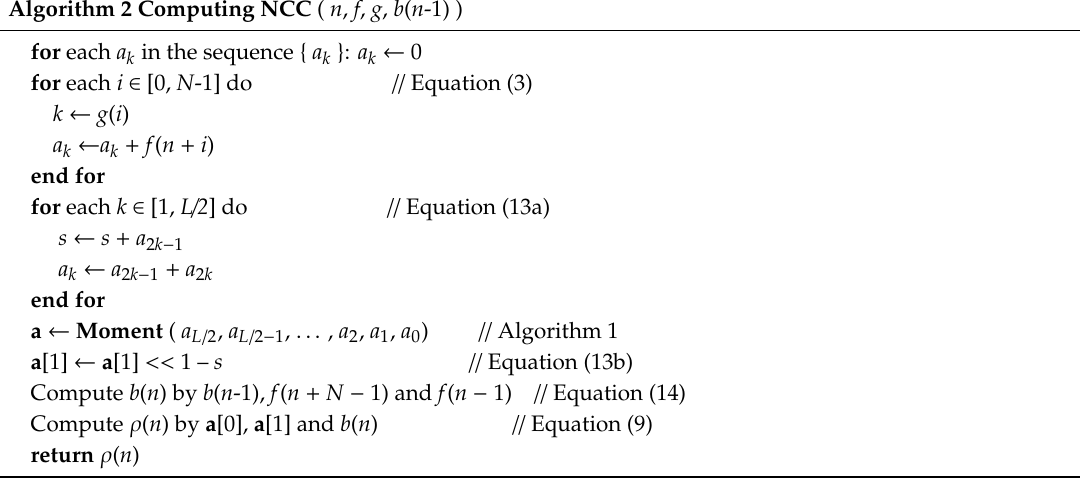
Algorithm 2 Computing NCC ( n , f , g , b ( n -1)